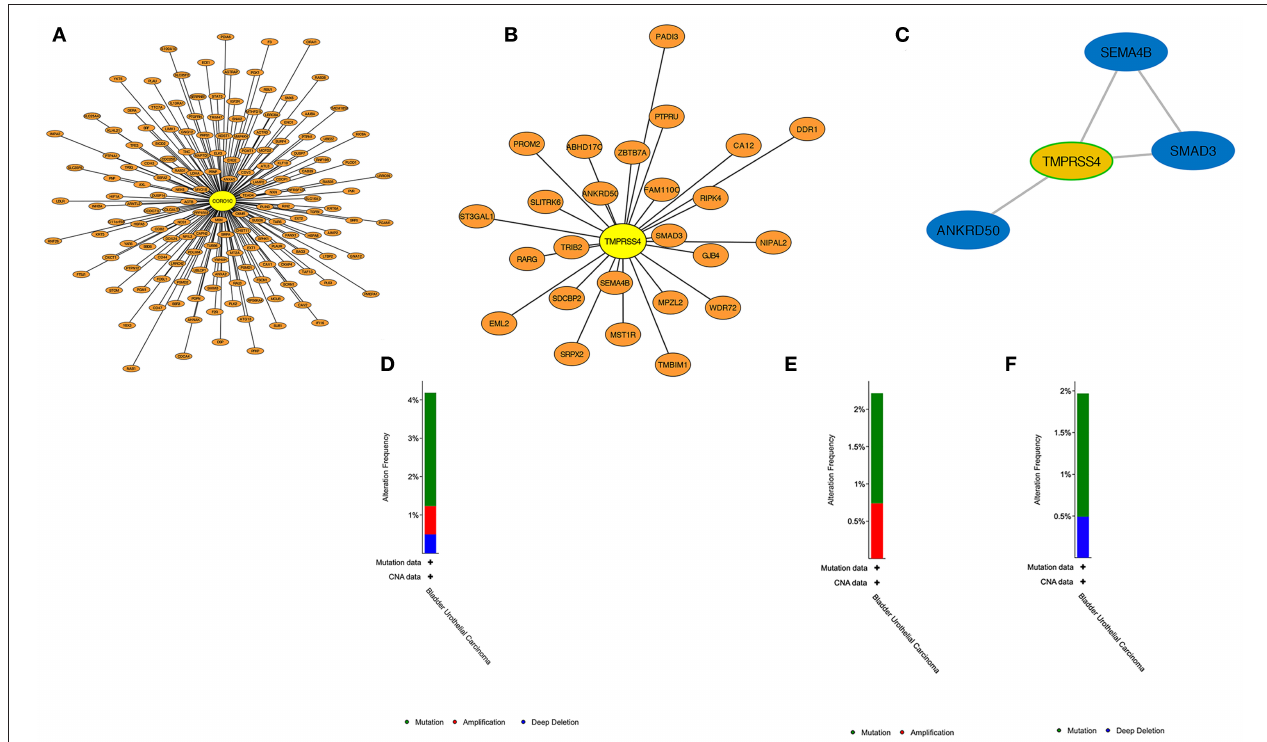
FIGURE 8 | PPI construction and genetic alteration analysis. (A) In WGCNA purple modules, genes highly related to CORO1C were established in a protein network. (B) In WGCNA light green modules, protein interaction of genes highly related to TMPRSS4. (C) The strongest weighted genes network in WGCNA light green module. (D) The overall genetic alternation status of two hub genes in TCGA-BLCA data. (E) The alternation type and frequency of CORO1C and (F) TMPRSS4, respectively, in TCGA-BLCA